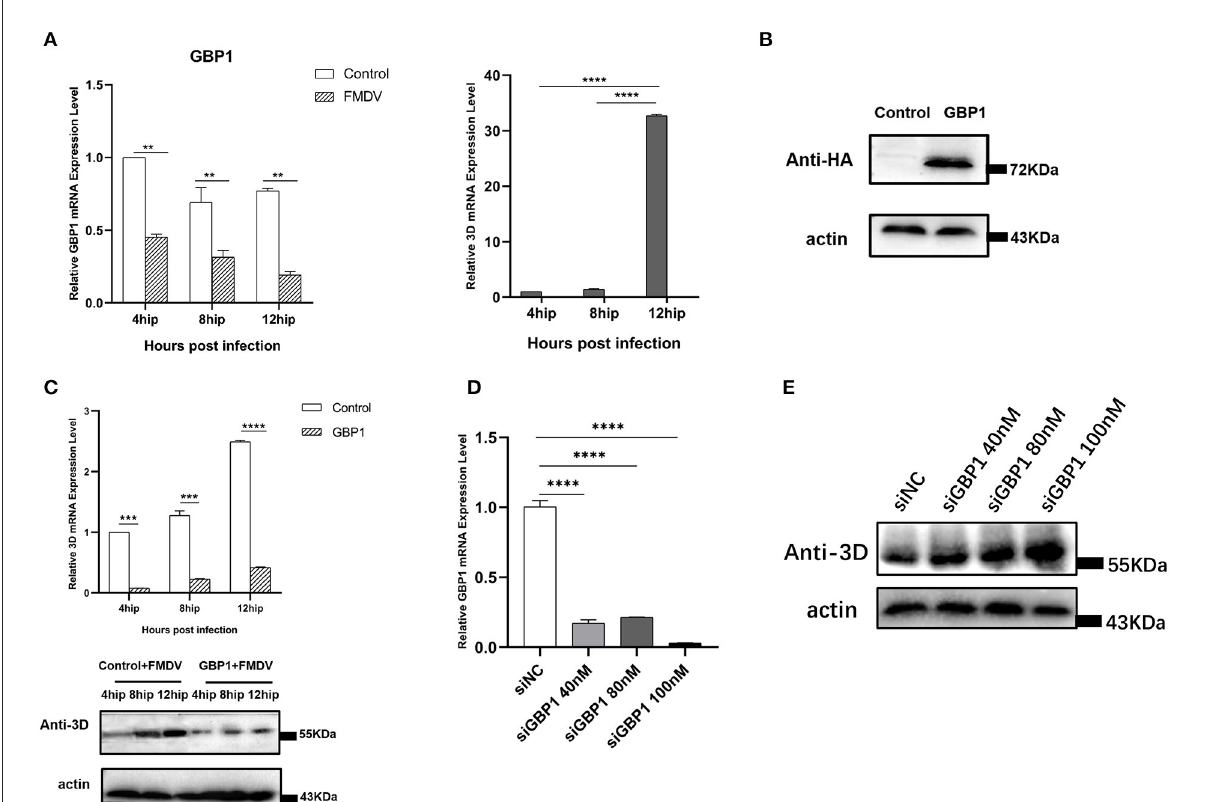
FIGURE6 The relationship between GBP1 and viral replication. (A) FMDV infection downregulates GBP1 mRNA expression. After infection of PK-15 cells with FMDV for 4, 8, and 12h, the mRNA levels of GBP1 and 3D in the samples were detected by qRT-PCR. (B,C) GBP1 inhibits FMDV replication. PK-15 cells were transfected with pCAGGS-HA-GBP1 plasmid for 24h, followed by infection with FMDV for 4, 8, or 12h. The viral RNA was determined by qPCR assay ( C , upper panel), the GBP1 (B) and viral 3D protein ( C , lower panel) was detected by Western blot. (D,E) Influence of GBP1 knockdown on FMDV replication. PK-15 cells were transfected with siGBP1 (siGBP1-597) in indicated concentration or siNC for 36h, followed by infection with FMDV for 12h. Knockdown of GBP1 mRNA was determined by qRT-PCR (D) , the viral 3D protein was detected by Western blot (E)